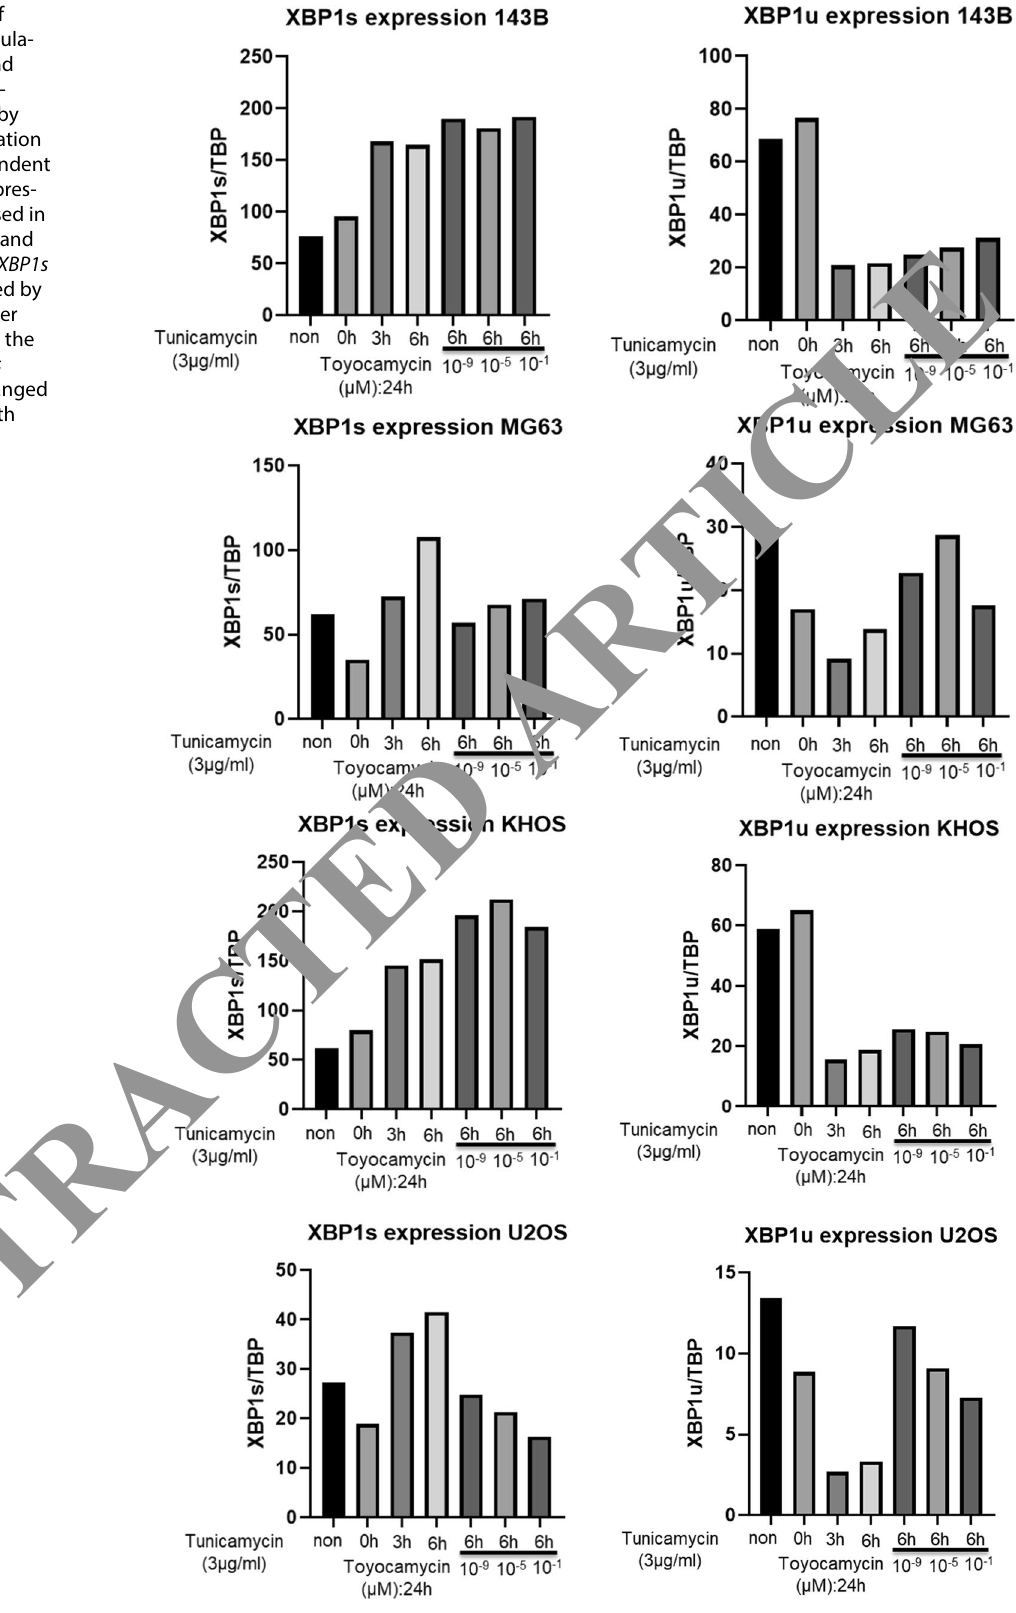
Fig. 5 Expression level of XBP1s and XBP1u by stimula- tion with tunicamycin and toyocamycin. The expres- sion of XBP1s is induced by tunicamycin (TM) stimulation (3 µg/ml) in a time-dependent manner, whereas the expres- sion of XBP1u is suppressed in all OS cell lines. In MG63 and U2OS, the expression of XBP1s induced by TM is inhibited by toyocamycin. On the other hand, in 143B and KHOS, the expression level of XBP1s induced by TM is not changed clearly by stimulation with